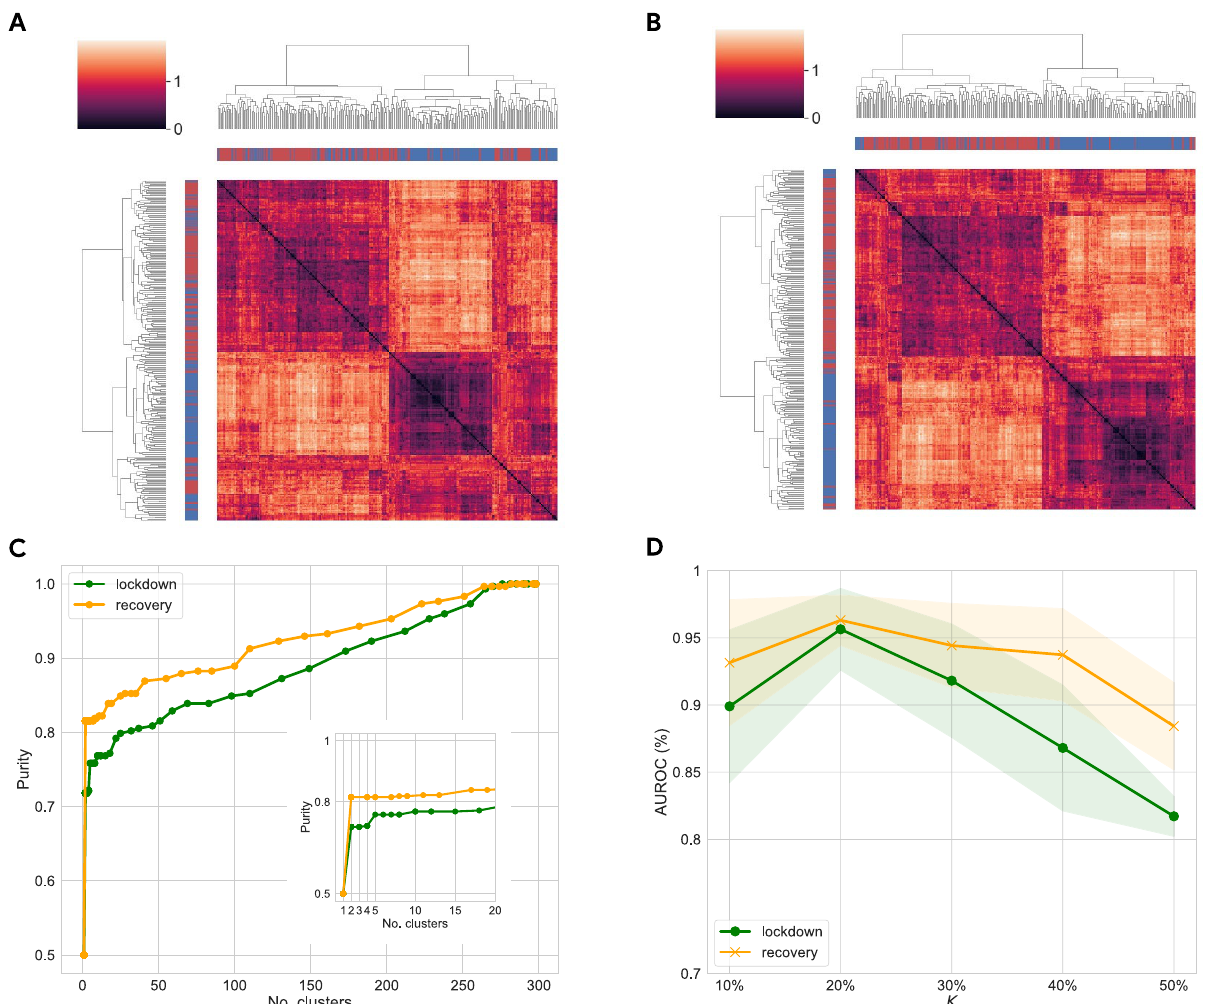
Figure 3. ( A , B ) Results of hierarchical clustering using features of the most and the least affected LLMs identified with lockdown ( A ) and recovery ( B ) indicators, with K = 30% . Red and blue labels of rows and columns identify respectively the most and the least affected areas. ( C ) Plot of purity score vs number of clusters for lockdown (green) and recovery (orange) dendrograms, shown respectively in panels ( A ) and ( B ). In the recovery phase, the two classes are more homogeneous and better separated, as indicated by purity scores higher compared to the lockdown period. This might signal that the effects of lockdown were more uniformly applied among LLMs, whereas recovery dynamics present more heterogeneity which allows us to better identify the most and the least affected territories. ( D ) Area under the Receiving Operator characteristic Curve (AUROC) for a Random Forest classifier evaluated on features of the most and the least affected LLMs, using lockdown (green) and recovery (orange) indicators and different values of K to obtain the binary label. Note the best performance for K = 20%, with AUROC values around 95% for both indicators. Similar to panel ( C ), we observe in general better results when identifying the most and the least affected LLMs during the recovery which strongly characterizes the mobility response of all LLMs, regardless of classes. Furthermore, by analyzing both lockdown and recovery performance of LLMs, we are interested in understanding the extent to which the impact of socioeconomic characteristics on mobility performance is stable over time, thus affecting LLMs both before and after the implementation of mobility restrictions. To do so, we perform a quantile regression 73 in which the dependent variable corresponds, in turn, to the lockdown and recovery indicators defined in the previous section. The quantile regression method allows us to estimate specific coefficients for the explanatory variables in each quantile of the distribution of variation in mobility, investigating the existence of different effects involving the tails of the distribution. In contrast, a traditional Ordinary Least Squares (OLS) regression, assumes a uniform relationship between the distributions of the predictors and the one of the dependent variable, providing only a single coefficient. Our purpose is to analyze the role of socioeconomic variables on the resilience of territories. We focus, in particular, on the relationship between income per capita and mobility variation. To account for the role of other socioeconomic dimensions, we include the economic structure of territories in the econometric model and we employ a proxy of sectoral productivity (revenues per employee of each sector) to control for the influence of